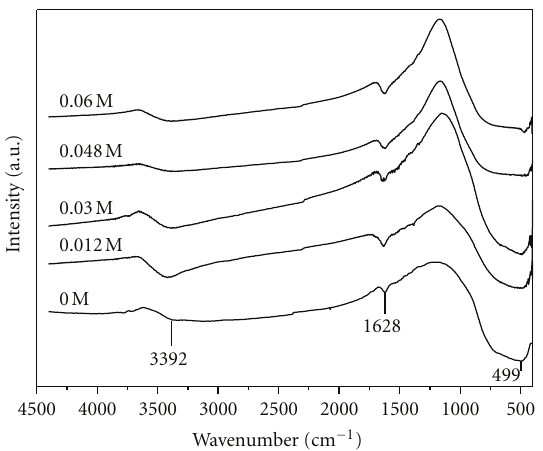
Figure 3: FT-IR spectra of mesoporous TiO 2 -Al 2 O 3 binary oxides prepared using di ff erent concentration of